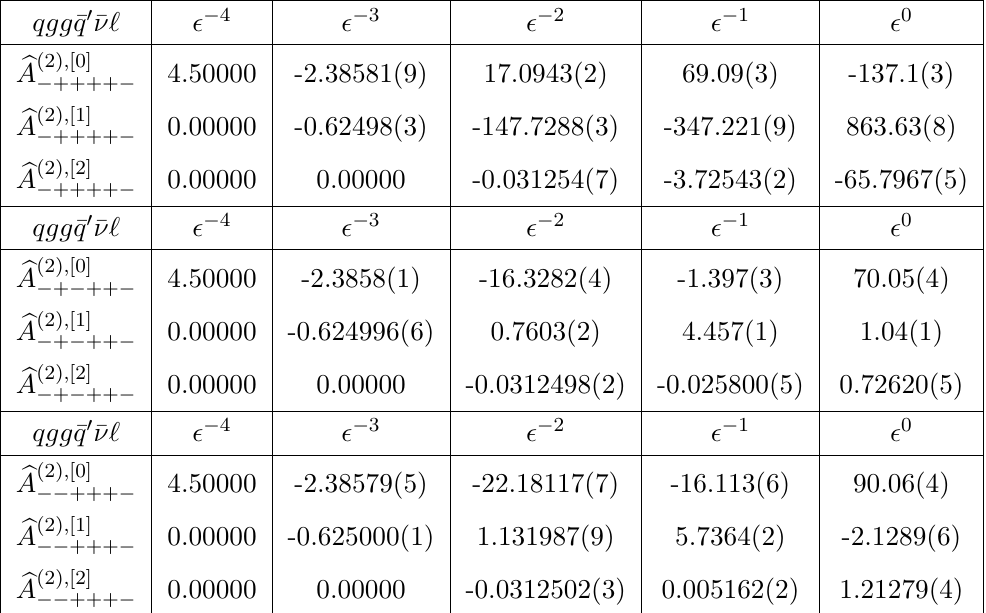
Table 3 . The numerical results of ^ A (2) ; [ i ] (1 q ; 2 g ; 3 g ; 4 (cid:22) q 0 ; 5 (cid:22) (cid:23) ; 6 ‘ ) using kinematic point in eq. (5.1) for each ( d s 2) component. (cid:0)